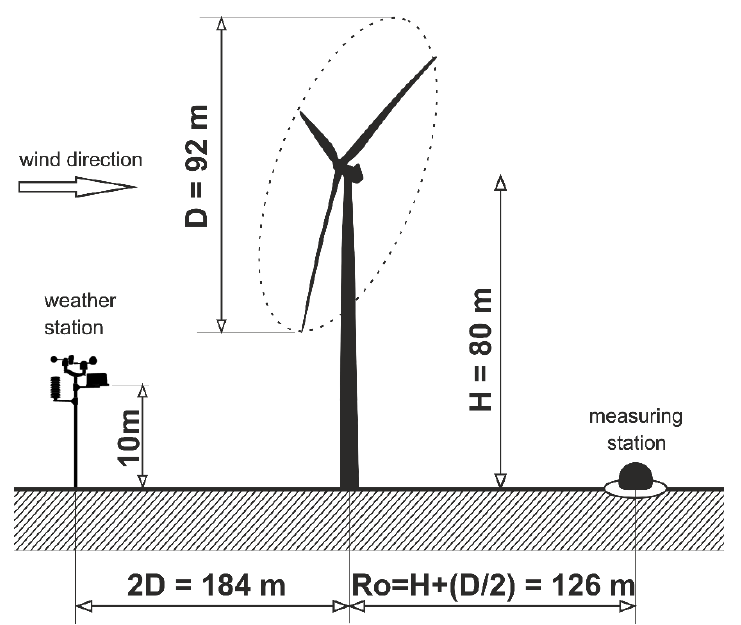
Figure 2. Scheme of the measuring system: example location of the microphone and the meteoro- logical station in relation to the tested wind turbine in accordance with the PN-EN 61400-11 stand- ard.